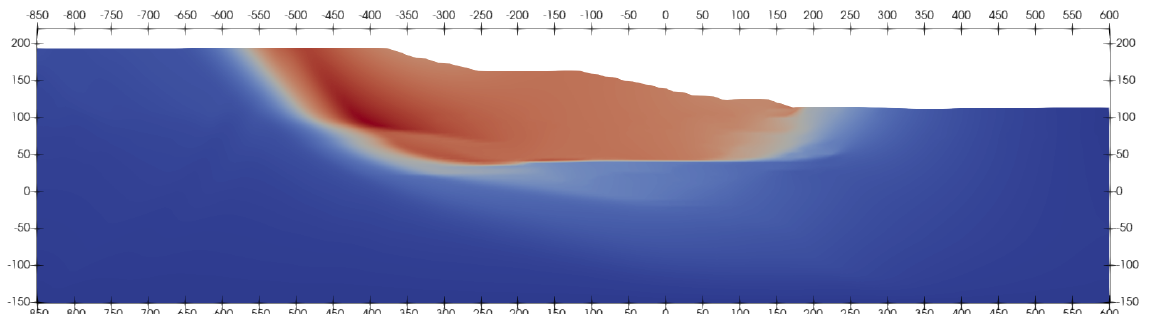
Figure 20: Failure surface at step 250 for dataset